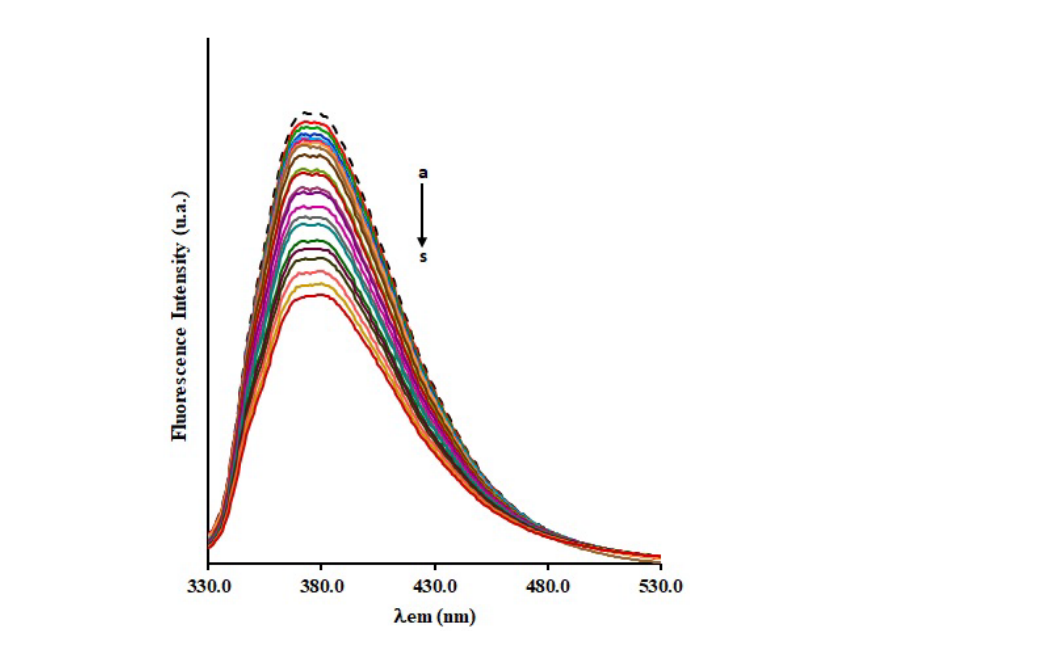
Figure 6. Effect of the [Ru( η 5 -C 5 H 5 )( m TPPMS)(bopy)][CF 3 SO 3 ] complex on the fluorescence emission spectra of {HSA-warfarin system}. The concentration of {HSA-warf} was 2.5 μM (a) and that of [Ru( η 5 -C 5 H 5 )( m TPPMS)(bopy)][CF 3 SO 3 ] was increased from 0 to 45 μM (b → s), with increments of 2.5 μM; 10 mM HEPES buffer, pH 7.4, incubation at 37 °C during 24 h. Each color represents an HSA:Ru ratio (a → s).